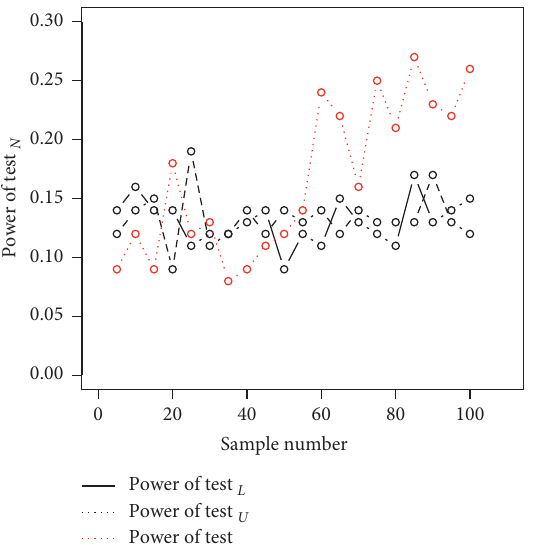
Figure 6: Comparison of the proposed test and the existing test for neutrosophic Weibull distribution.